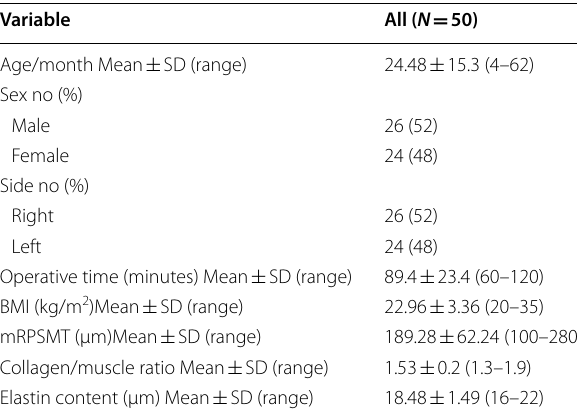
Table 1 Distribution of the studied group